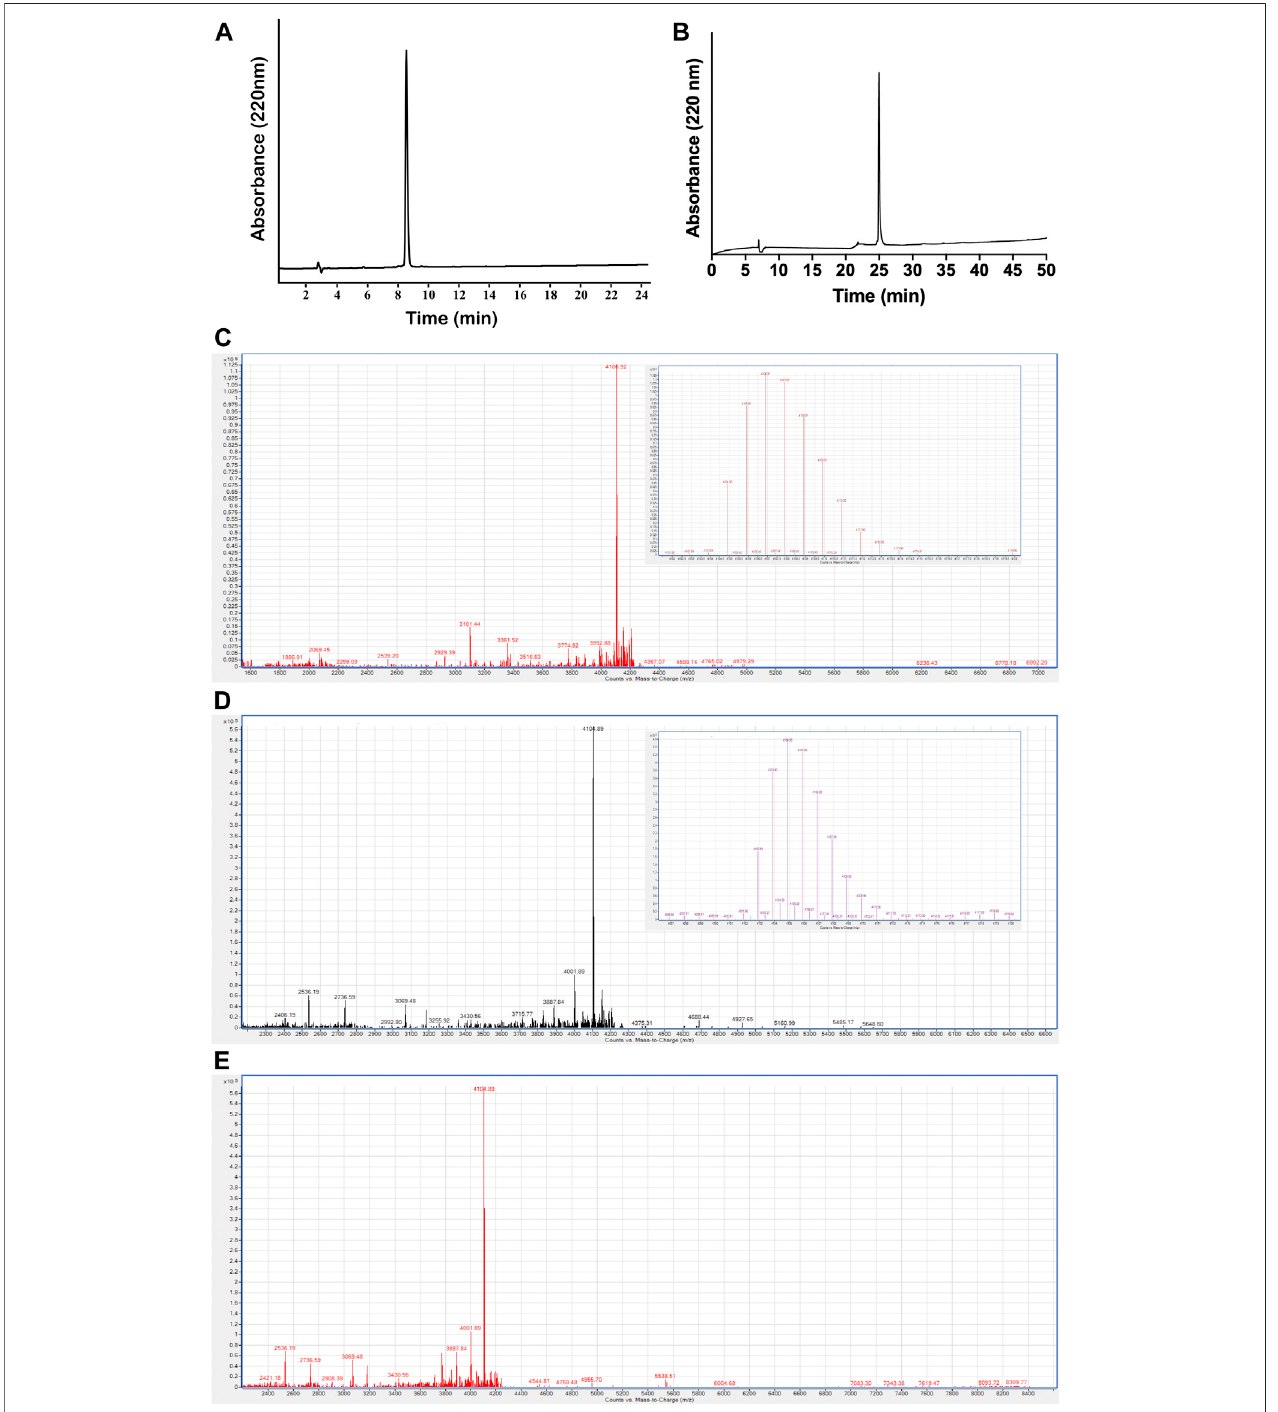
FIGURE 3 | Puri fi cation and characterization of PcActx peptides. (A) . Analytical RP-HPLC chromatograph for the fi nal puri fi ed linear PcActx peptide with absorbance at 220 nm with purity ≥ 90%. (B) . Analytical RP-HPLC chromatograph for the fi nal puri fi ed oxidized PcActx peptide with absorbance at 220 nm with purity ≥ 90%. (C) .ESI-MSanalysisoflinearPcActxpeptide.Anal.calcdforC + 4104.89 Da(monoisotopicmass),found[M+H] + 4104.90 Da. (D) .ESI- 182 H 265 N 53 O 51 S 3 [M+H] MS analysis of oxidized PcActx peptide. Anal. calcd for C 182 H 263 N 53 O 51 S 3 [M + H] + 4102.87 Da (monoisotopic mass), found [M + H] + 4102.88 Da. (E) . ESI-MS analysis of oxidized PcActx peptide incubated in dd-H 2 O for 48 h.